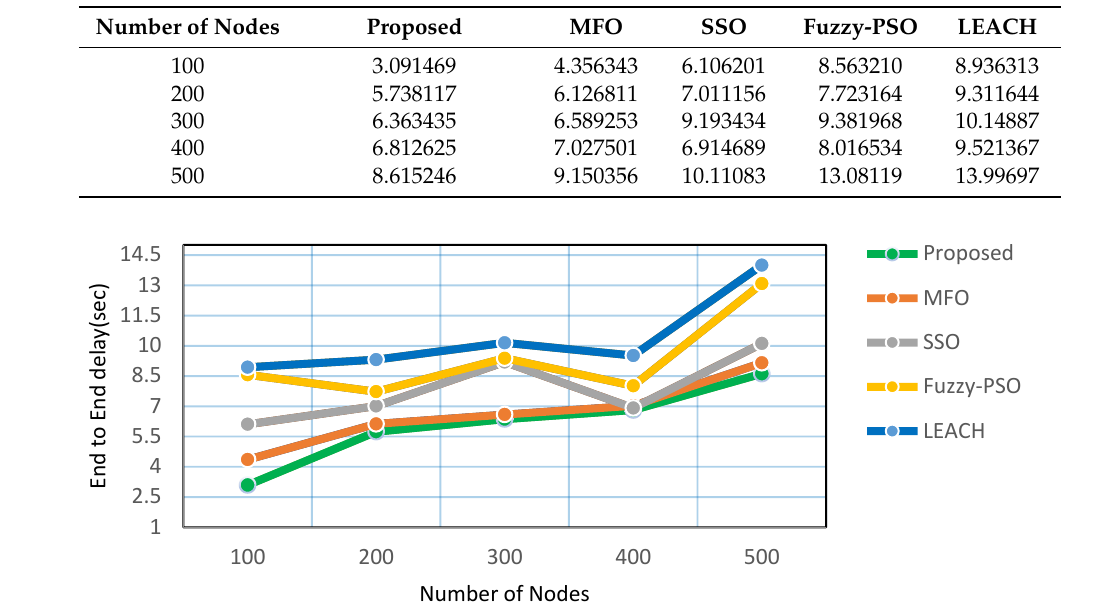
Figure 5. Analysis of End-to-End delay vs. number of nodes.